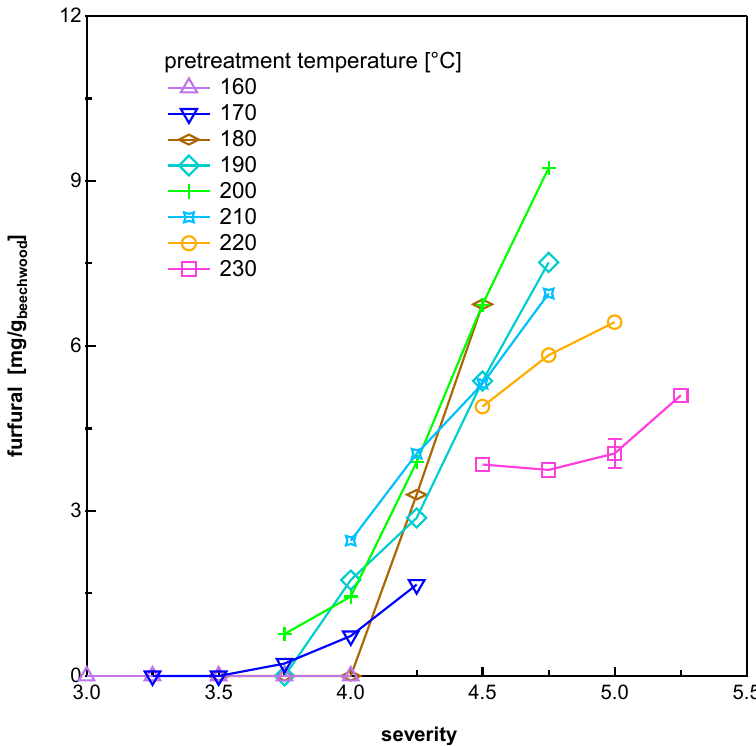
Figure 7. Formation of furfural during steam explosion pretreatment. The amount of furfural that is released into the prehydrolyzate during steam explosion pretreatment is shown as a function of the pretreatment severity and